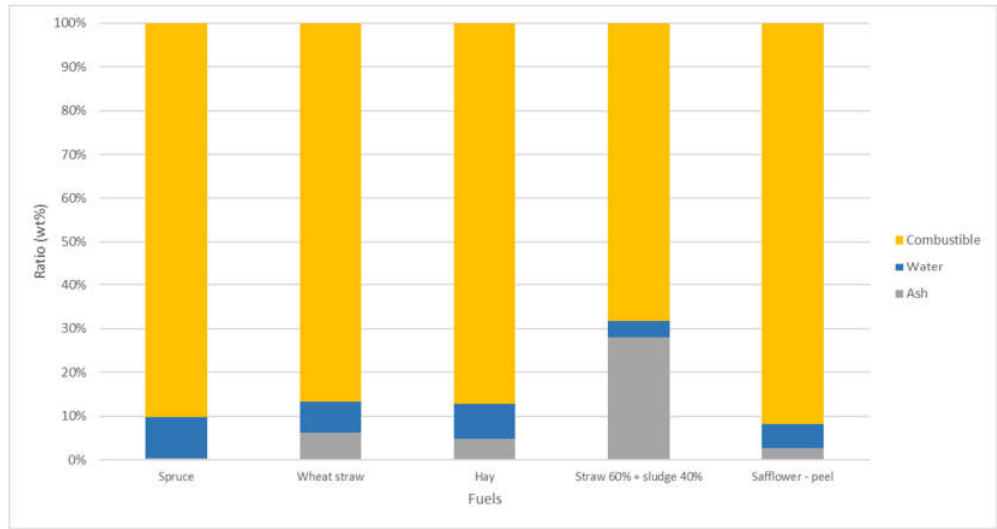
Figure 1. Total ratio of combustible content, water, and ash in the selected materials. Table 3. Evaluation of the rough analysis of the selected samples.